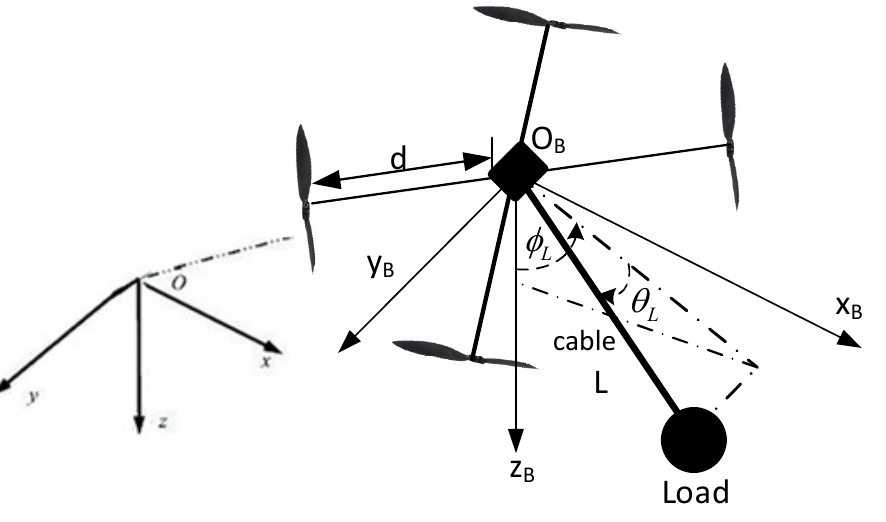
Figure 1. Quadrotor with a suspended load.